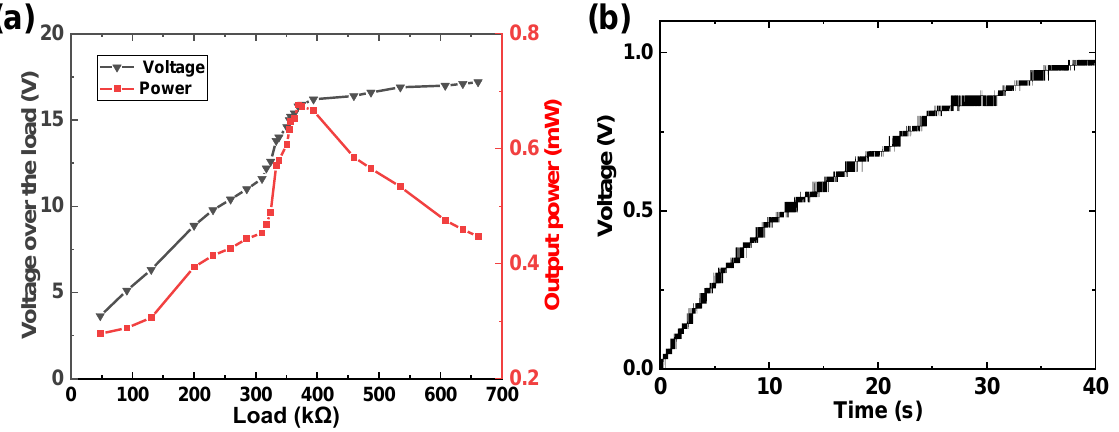
Figure 9. The output capacity of the proposed PPEH: ( a ) optimal load and corresponding output power; ( b ) the charged voltage over a 2200- μF capacitor.